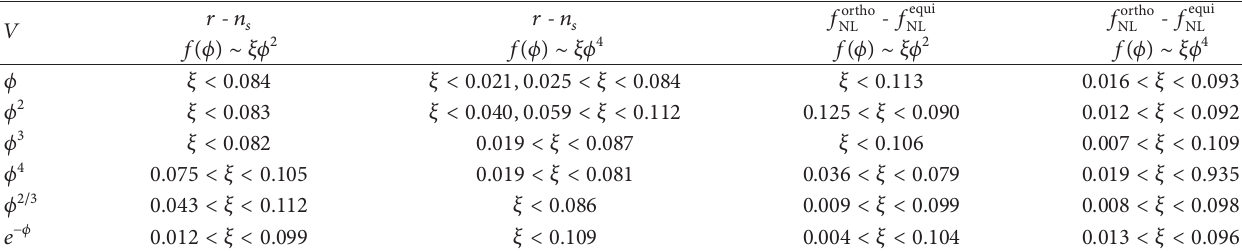
Table 4: The ranges of 𝜉 in which the values of the inflationary parameters 𝑟 and 𝑛 𝑠 and also 𝑓 ortho NL and 𝑓 equi NL , with 𝑛 = 4 , are compatible with the 95 % CL of the Planck 2015